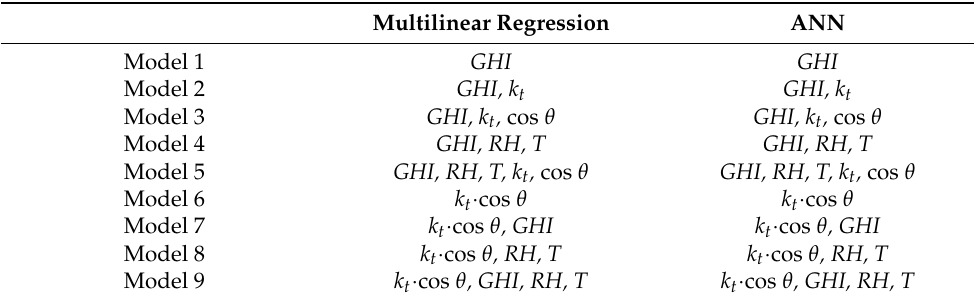
Table 2. Set of variables used in each